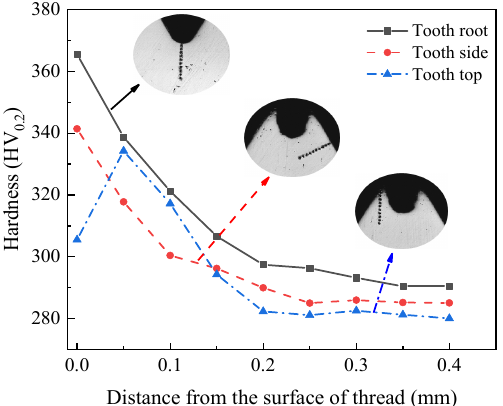
Figure 28. Measurement of thread hardness after